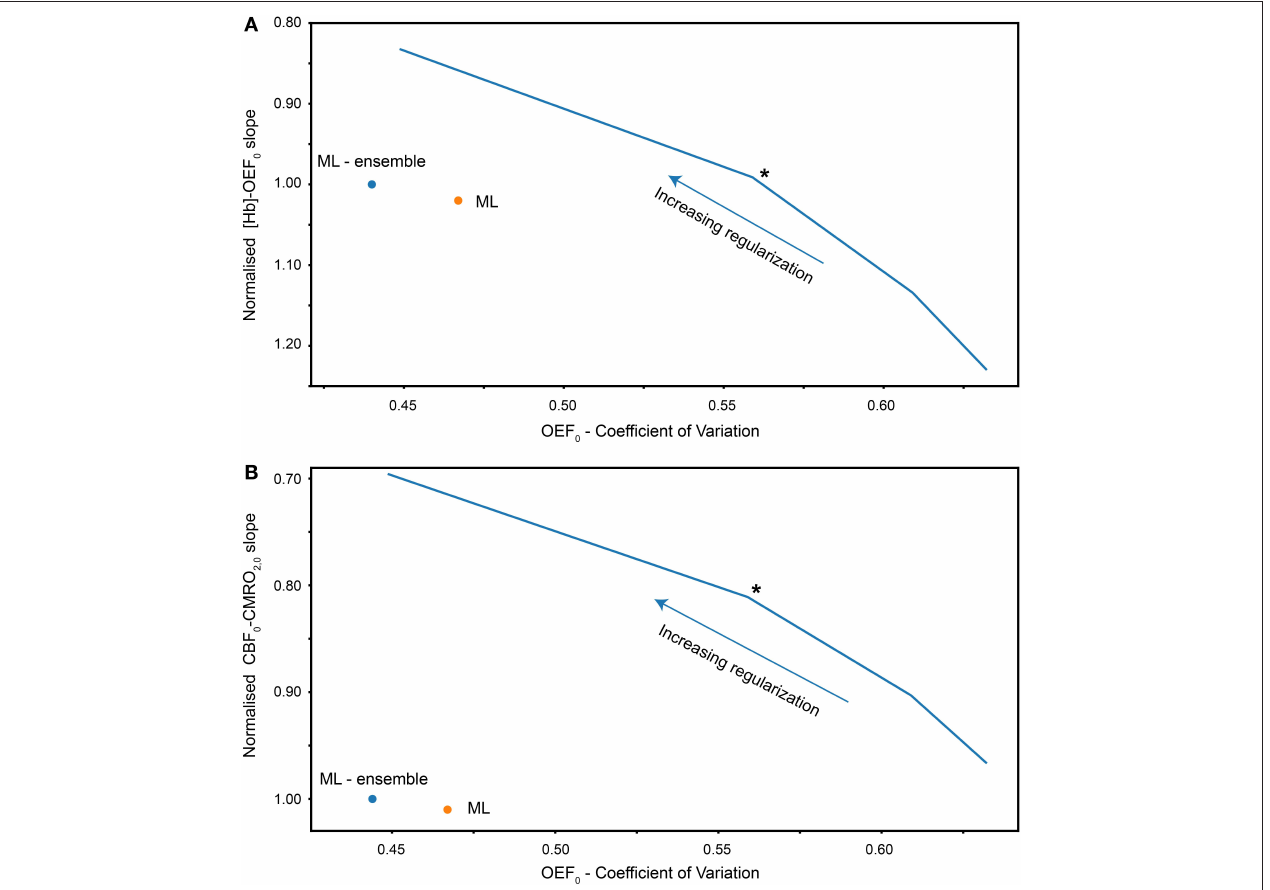
FIGURE 4 | (A) Coefficient of variation of gray matter OEF 0 estimates vs. slope of [Hb]-OEF 0 relationship for each analysis method (rNLS fitting evaluated with increasing levies of regularization). The [Hb]-OEF 0 slope has been normalized by the ML ensemble estimate of the [Hb]-OEF 0 slope. (B) Coefficient of variation of gray matter OEF 0 estimates vs. the slope of the CBF-CMRO 2 relationship, normalized by the ML (ensemble) estimate of the CBF-CMRO 2 slope. Solid blue line plots the coefficient of variation against the slope for increasing regularization weighting for regularized non-linear least squares analysis. The asterisk indicates the chosen level of regularization for subsequent